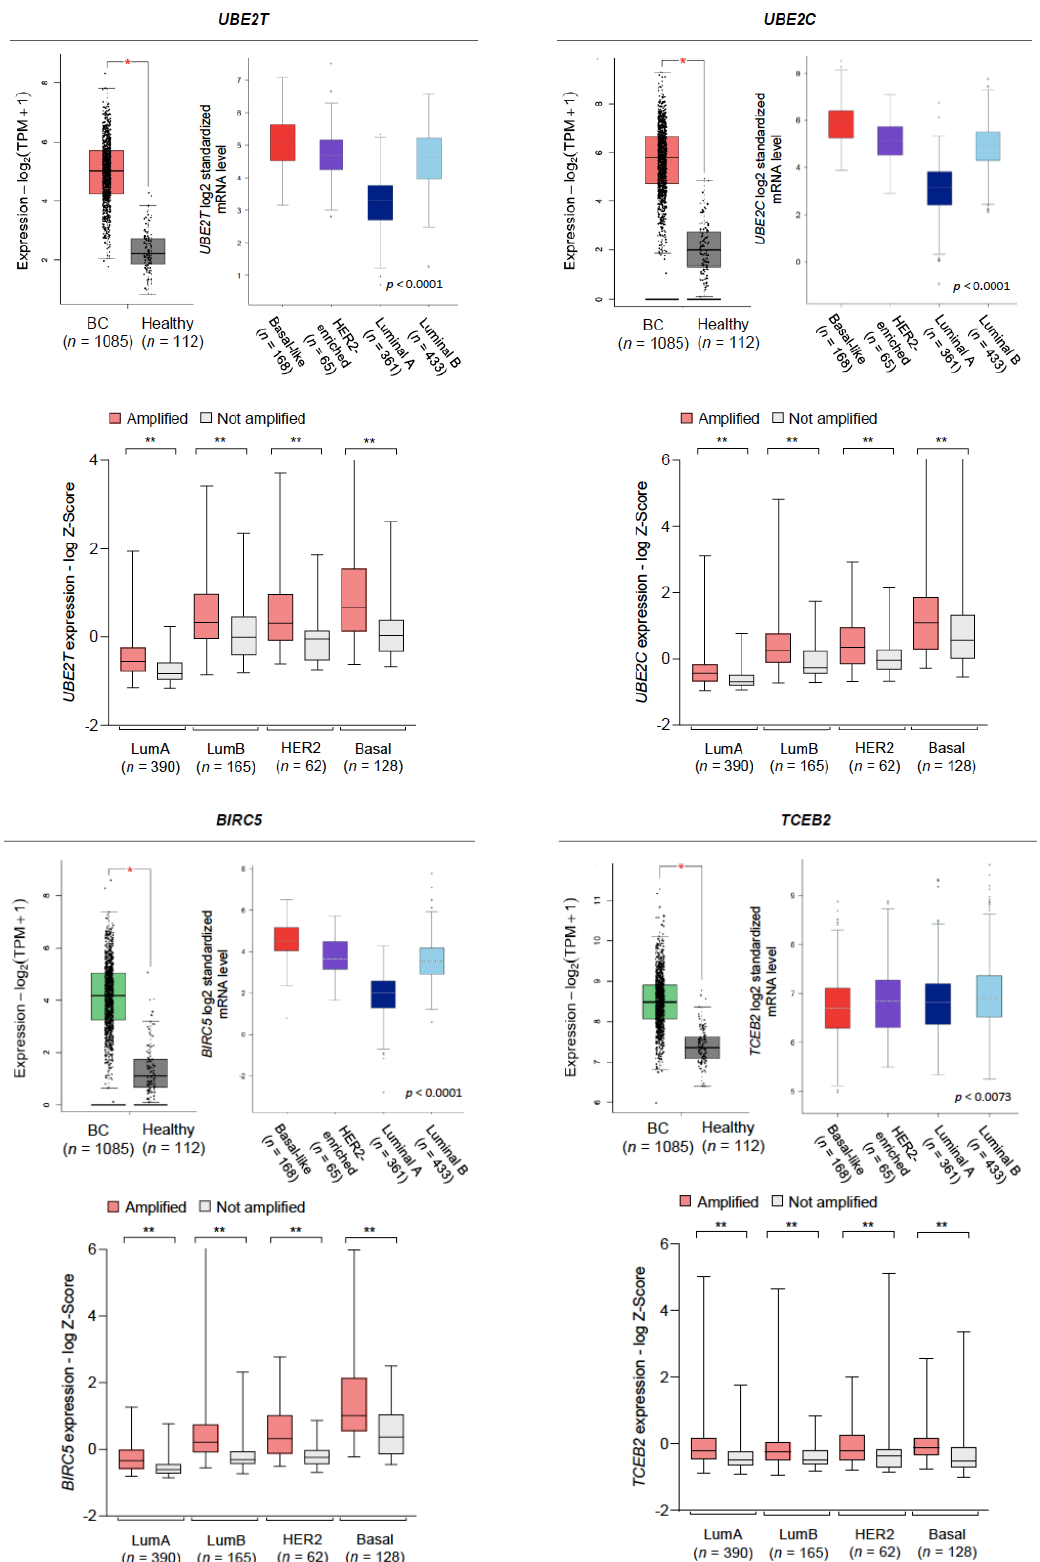
Figure 3. Expression levels of the most frequently amplified genes. Statistically significant differences in gene expression between tumor and healthy samples, along with the distribution of expression levels across intrinsic subtypes ( upper part ). Association of the amplification status with expression levels across intrinsic subtypes ( lower part ). Single asterisk denotes p < 0.05 and double asterisk denotes p < 0.01 using the Mann-Whitney test.